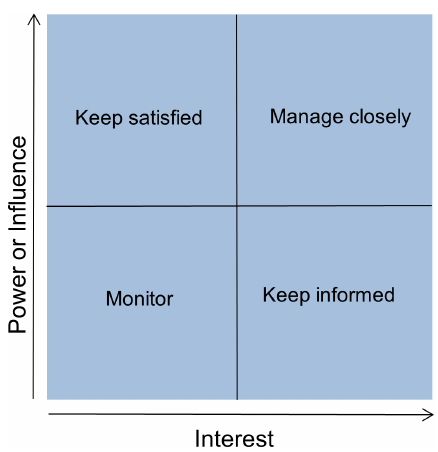
Figure 1. Stakeholder mapping tool. Determining the level of in- terest and influence (or power) of different stakeholders can help to ensure effective communication with each group. Figure adapted from Mendelow